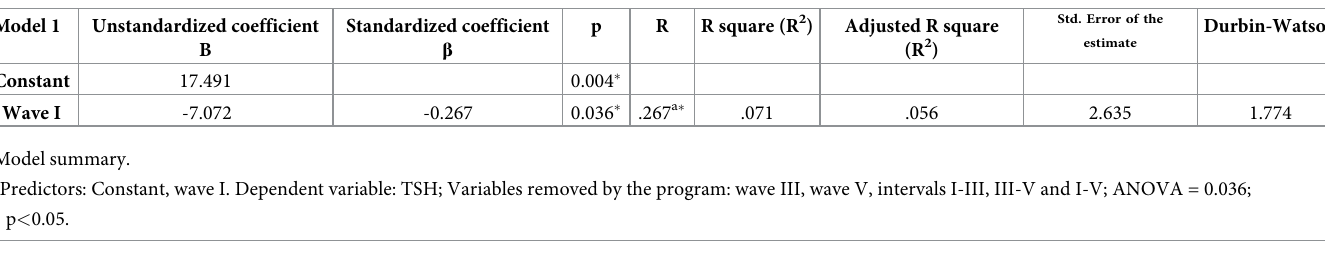
r = correlation coefficient; p = significance.